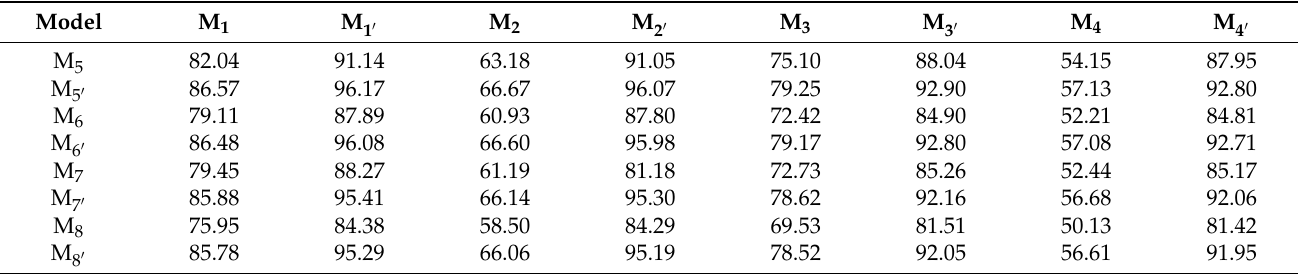
Table 4. Percentage of correct